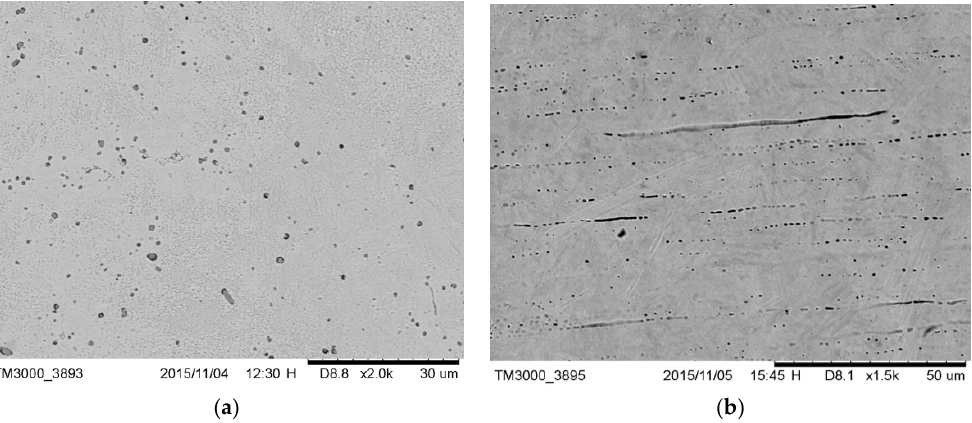
Figure 2. ( a ) Microstructure of drill E where sulfide precipitates were visible; ( b ) external surface of drill E; milling lines were visible.